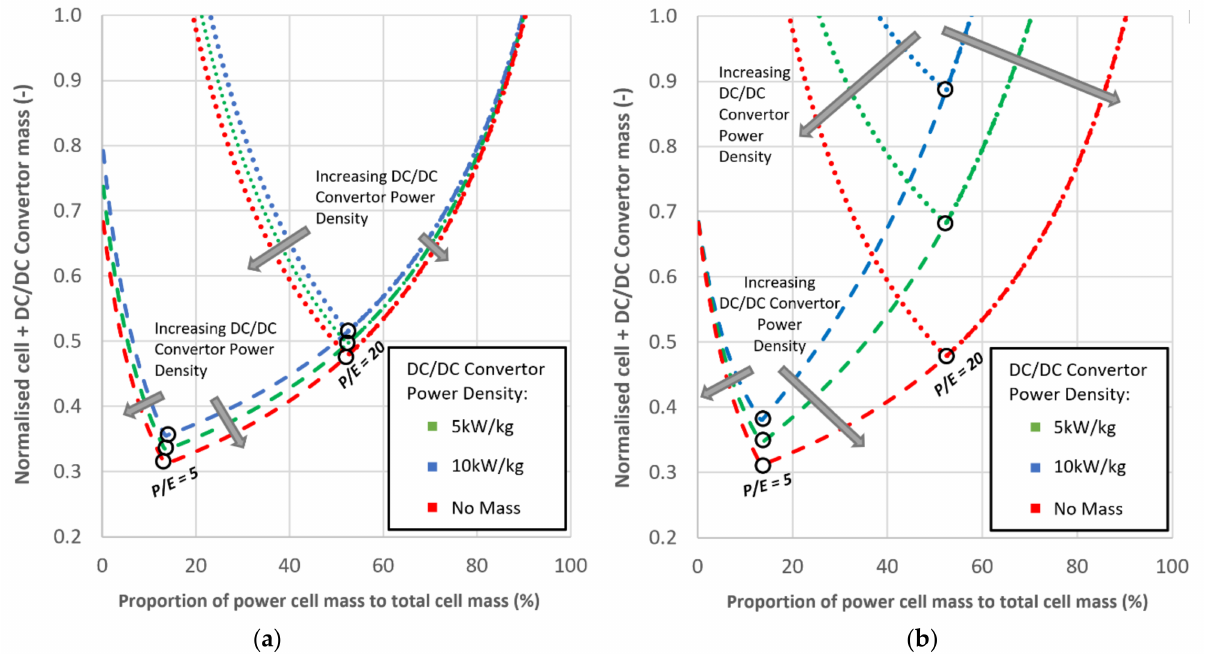
Figure 6. Overall total cell mass for a varying power-cell-to-total-cell mass ratio for PE 5 and PE 20 applications by considering the impact of ( a ) a DC/DC converter on the energy pack varying from 5 to 10 kW/kg and ( b ) a DC/DC converter on the power pack varying from 5 to 10